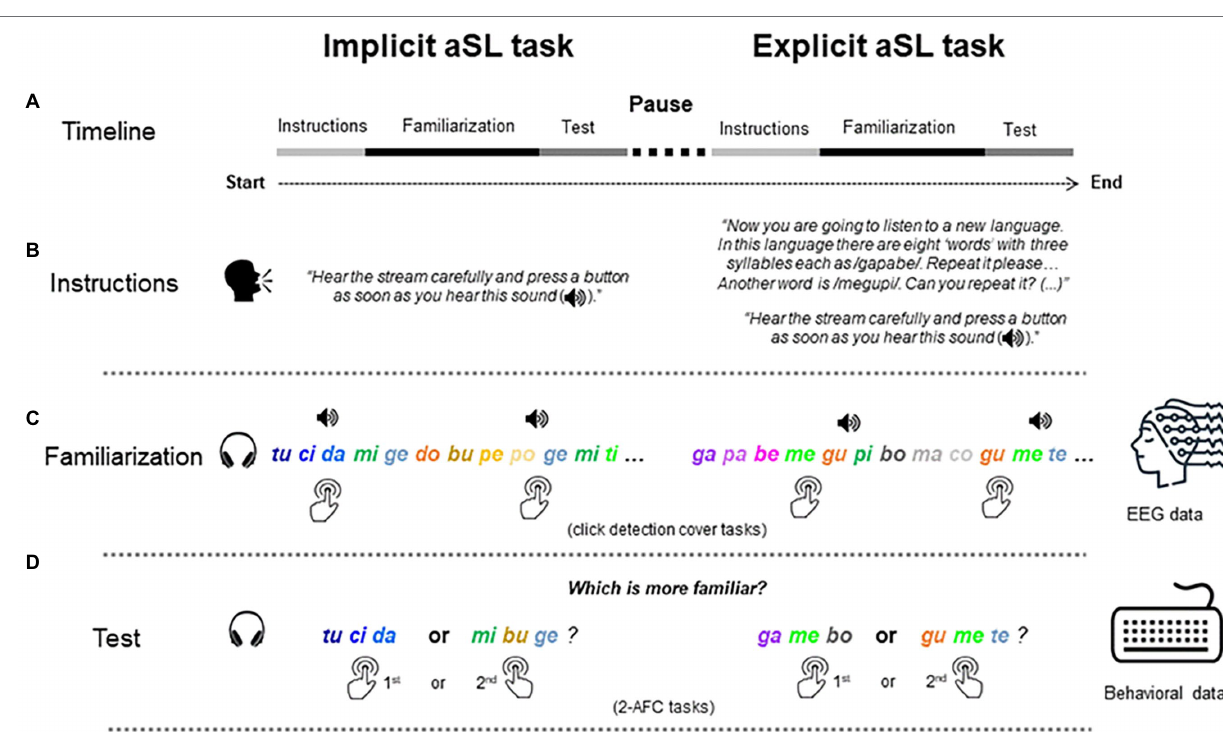
FIGURE 2 | Illustration of the experimental procedure. (A) Illustrates the timeline of the experimental procedure in which the implicit and, subsequently, the explicit aSL task were administered. Each aSL task comprised three parts: instructions (B) , familiarization (C) , and test (D) phases. Each task was initiated with specific instructions that determined the conditions under which each of the aSL tasks was performed either without (Implicit aSL) or with the previous knowledge of the task and the structure of the stream used in the experiment (Explicit aSL). In the familiarization or exposure phase of both tasks during which EEG data were collected, participants were presented with a continuous auditory stream of four high-TP and four low-TP “words,” with chirp sounds (depicted as a speaker icon on the figure) superimposed over specific syllables. The chirp sounds could emerge at any of the three syllable positions of the “words,” which precluded its use as a cue for “word” segmentation. During this phase, participants had to perform a chirp detection task. Then, the test phase in each of the aSL tasks consisted of a two-alternative forced-choice (2-AFC) task asking participants to indicate which of the three-syllable sequences (a “word” and a foil) sounded more familiar based on the stream presented during the previous familiarization phase.